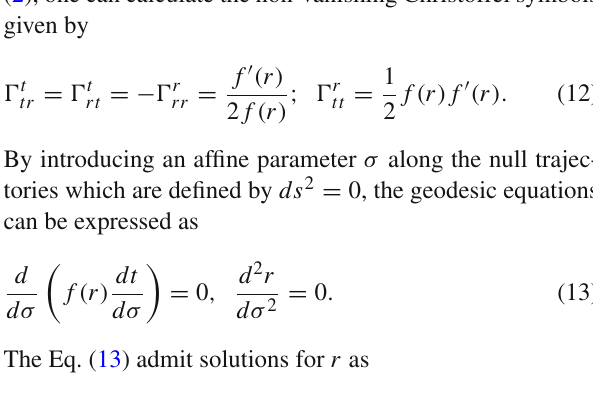
Fig. 2 a Spatial separation between two ingoing null rays along a τ − constant hyper-surface. b Spatial separation between two outgoing null rays along a τ + constant hyper-surface. c The spacelike and timelike √ coordinates for (cid:10) = 2 drawn on a Penrose diagram together with a collapsing shell of matter denoted by the shaded